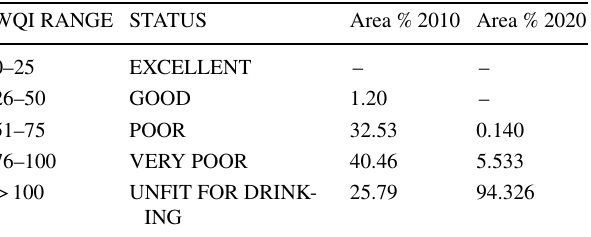
Table 6 Classification of WQI using weighted arithmetic method (Brown et al. 1972)